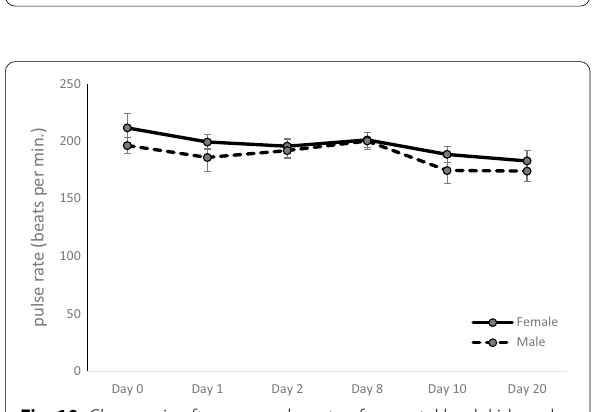
Fig. 10 Changes in afternoon pulse rate of neonatal buck-kids and doelings from birth to Day 20